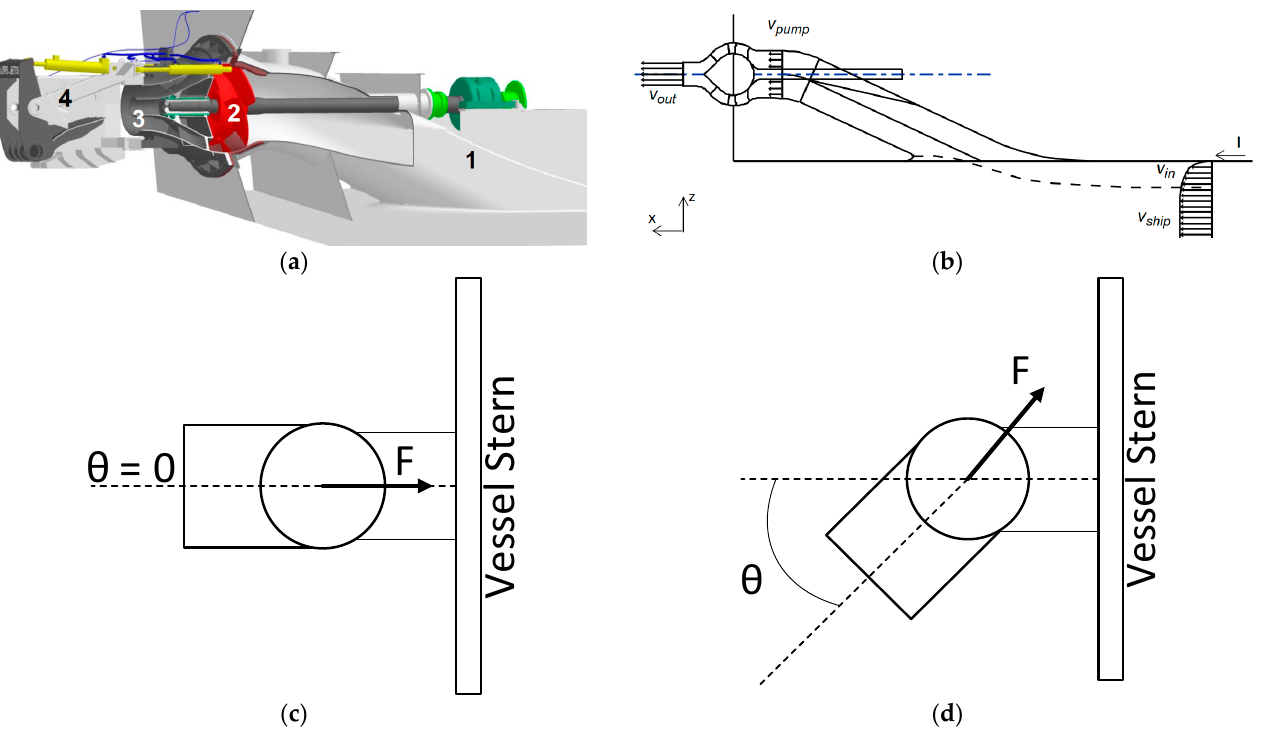
Figure 1. Waterjet schematic views. ( a ) Side-cut view; ( b ) functionality schematic; ( c ) top schematic view at zero turn; ( d ) top schematic view at θ turn.